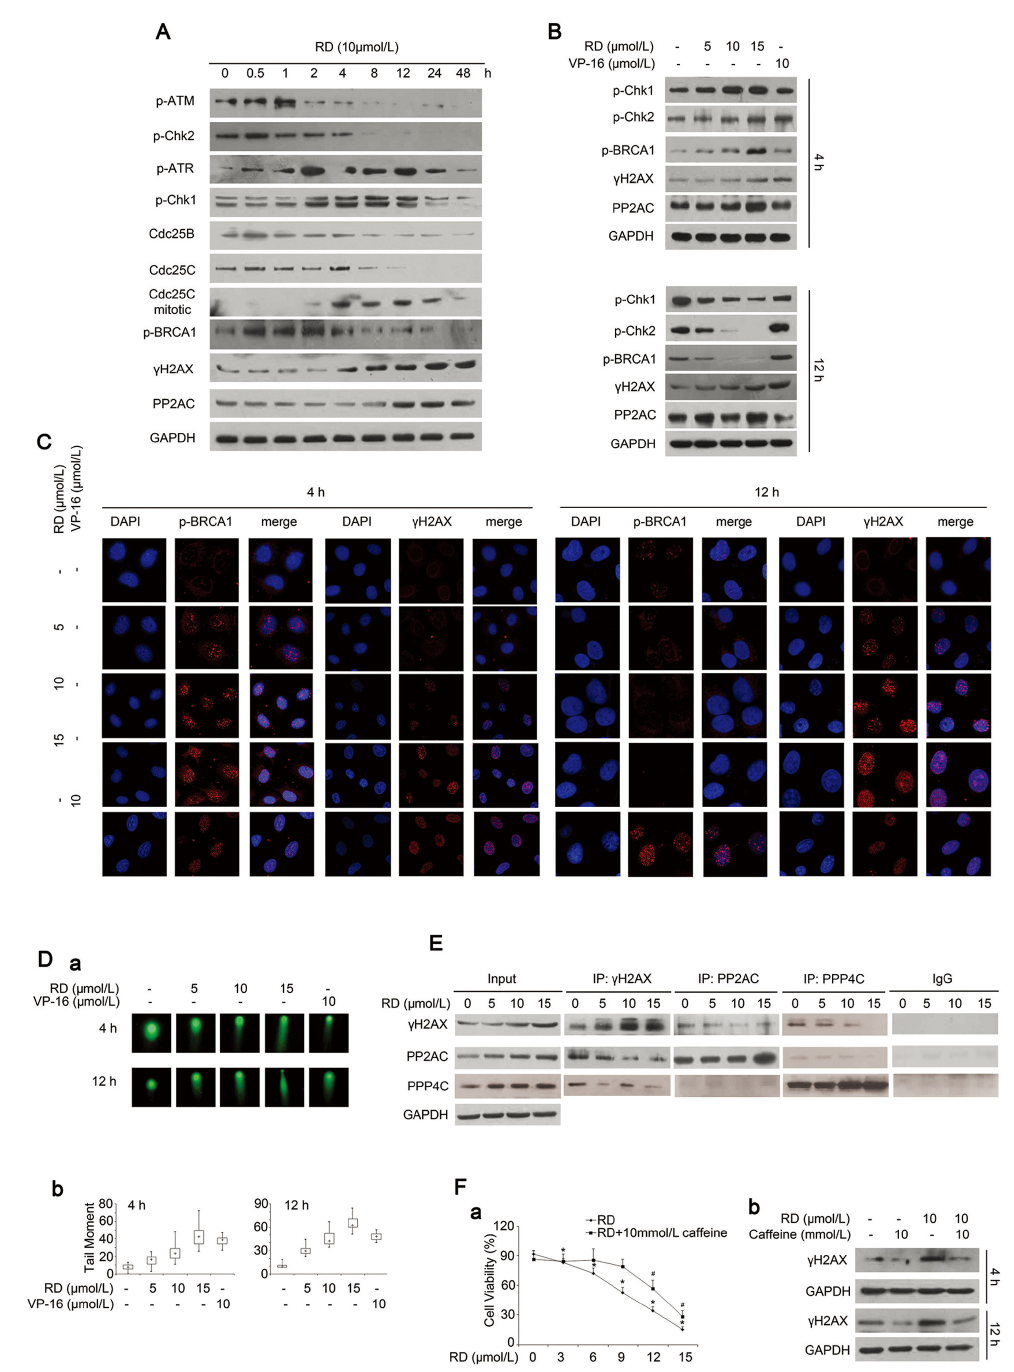
Figure 3. Effect of RD on DNA damage response signalings. A , Changes of DNA damage proteins in RD-treated cells were analyzed by western blotting. B , After treatment with chemicals for 4h or 12h, protein levels of DNA damage proteins were detected by western blotting. C , Immunofluorescence staining of γH2AX foci and p-BRCA1 foci in PC-3 cells. D , a , Neutral comet assay of PC-3 cells treated with RD for 4h and 12h. b , Comet length was analyzed by box and whisker plot method (100 cells per sample). E , Associations of γH2AX, PP2AC, and PPP4C were determined by coimmunoprecipitation using anti-γH2AX, anti-PP2AC, anti- PPP4C, or normal IgG. F , PC-3 cells were pretreated with 10 mmol/L caffeine for 1h, and exposed to RD for 4h and 12h, a , cell viability measured by MTT assay; bars, SD. *, # , P < 0.05, significant difference from control. b , changes of γH2AX were detected by western blotting. doi: 10.1371/journal.pone.0074387.g003 PLOS ONE |